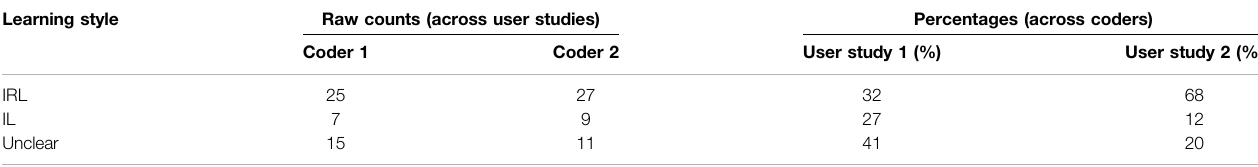
TABLE 1 | Coding of qualitative participant responses as resembling inverse reinforcement learning (IRL) or imitation learning (IL), or “ unclear. ” Learning